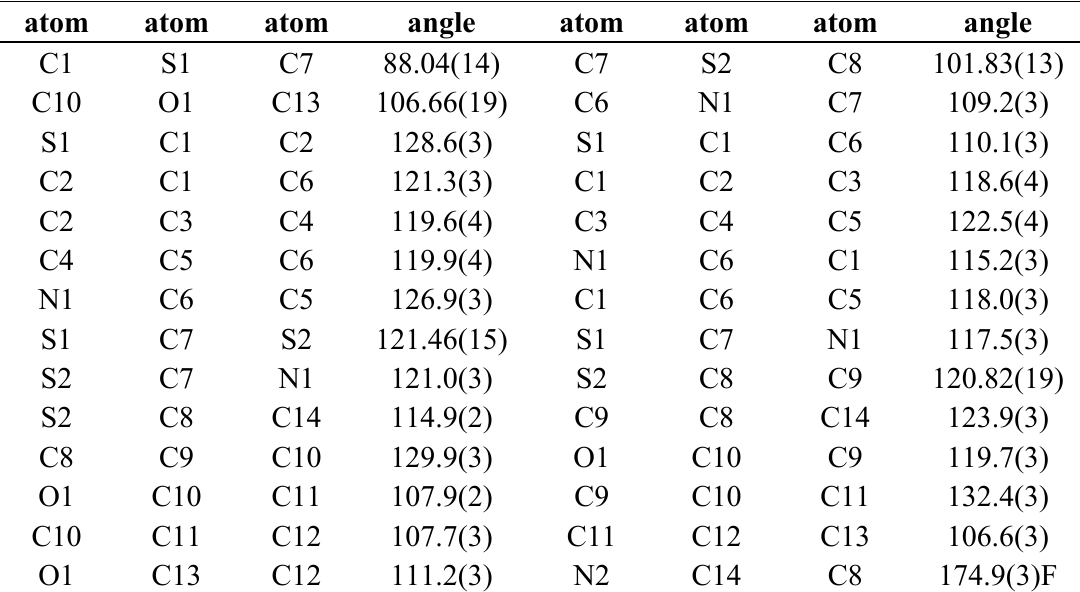
Table 6. Bond angles (o) for compound 4a